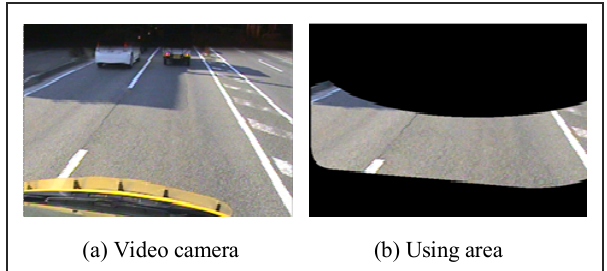
Figure 4. The area of orthophoto